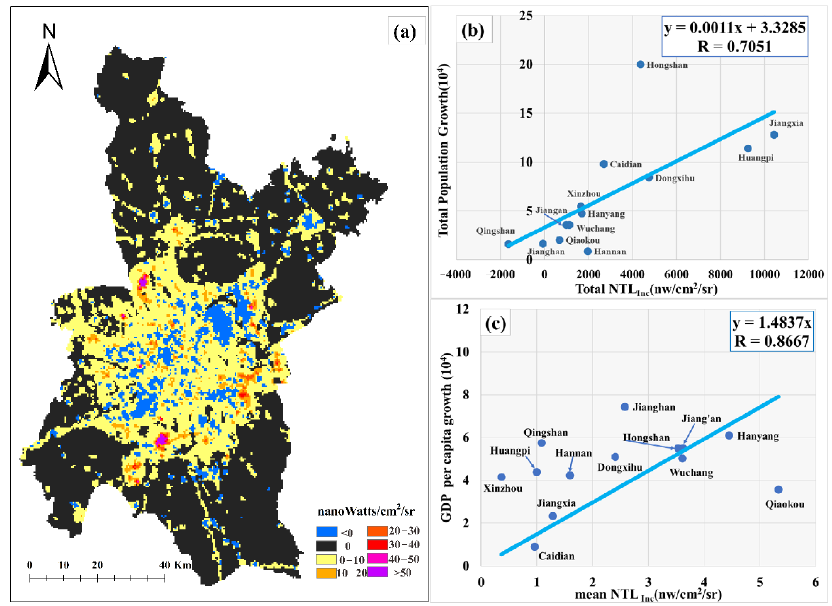
Figure 9. Dynamics NTL illumination in Wuhan during 2013–2018: ( a ) the increase of NTL radiance intensity during 2013–2018; ( b ) linear regression analysis between total population growth and total NTL Inc at the district scale; ( c ) linear regression analysis between GDP growth per capita and mean NTL Inc at the district